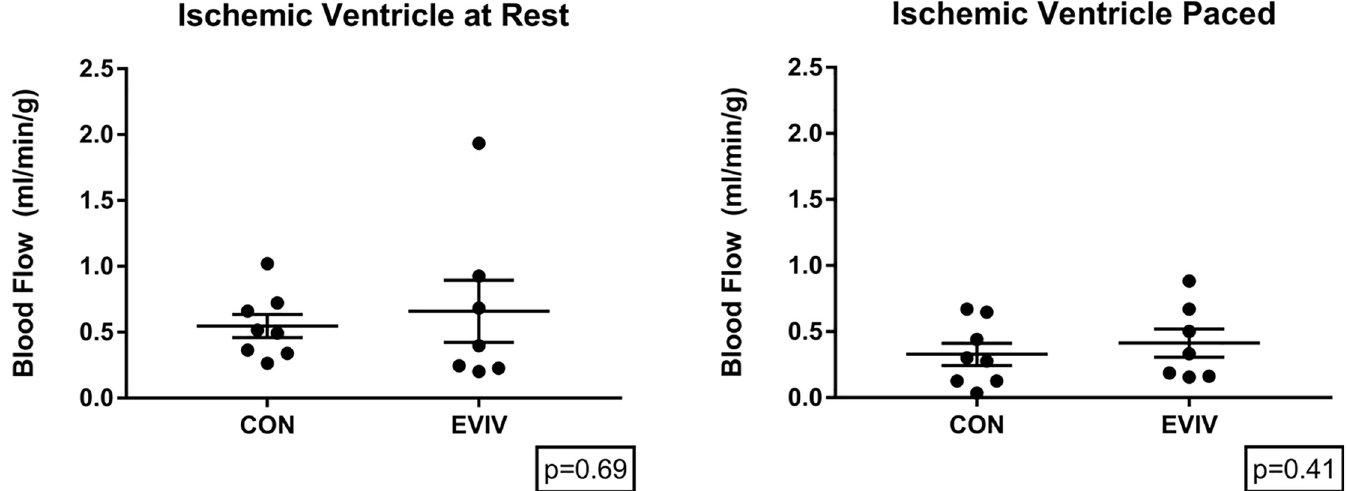
Fig 2. Intravenous injection of extracellular vesicles. No significant change was seen in blood flow (ml/min/g) either at rest or during pacing. CON: Control group, EVIV: Extracellular Vesicle Intravenous injection group.